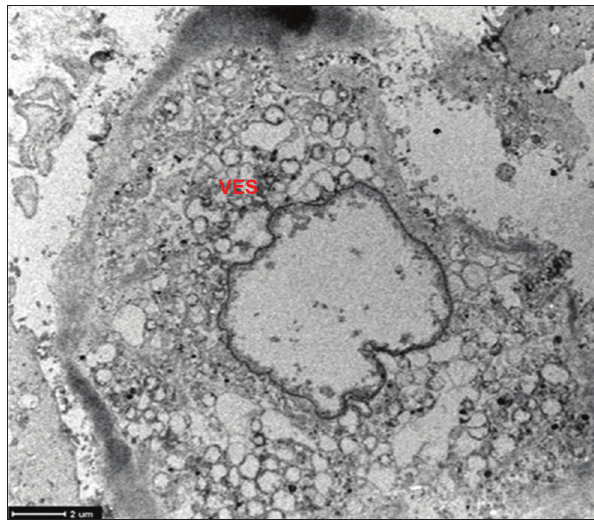
Figure-8: Transmission electron microscopy of adipose stem cell infected with canine distemper virus. Nucleus with peripheral chromatin and nuclear matrix lysis. VES=Double-membrane vesicle clusters in the